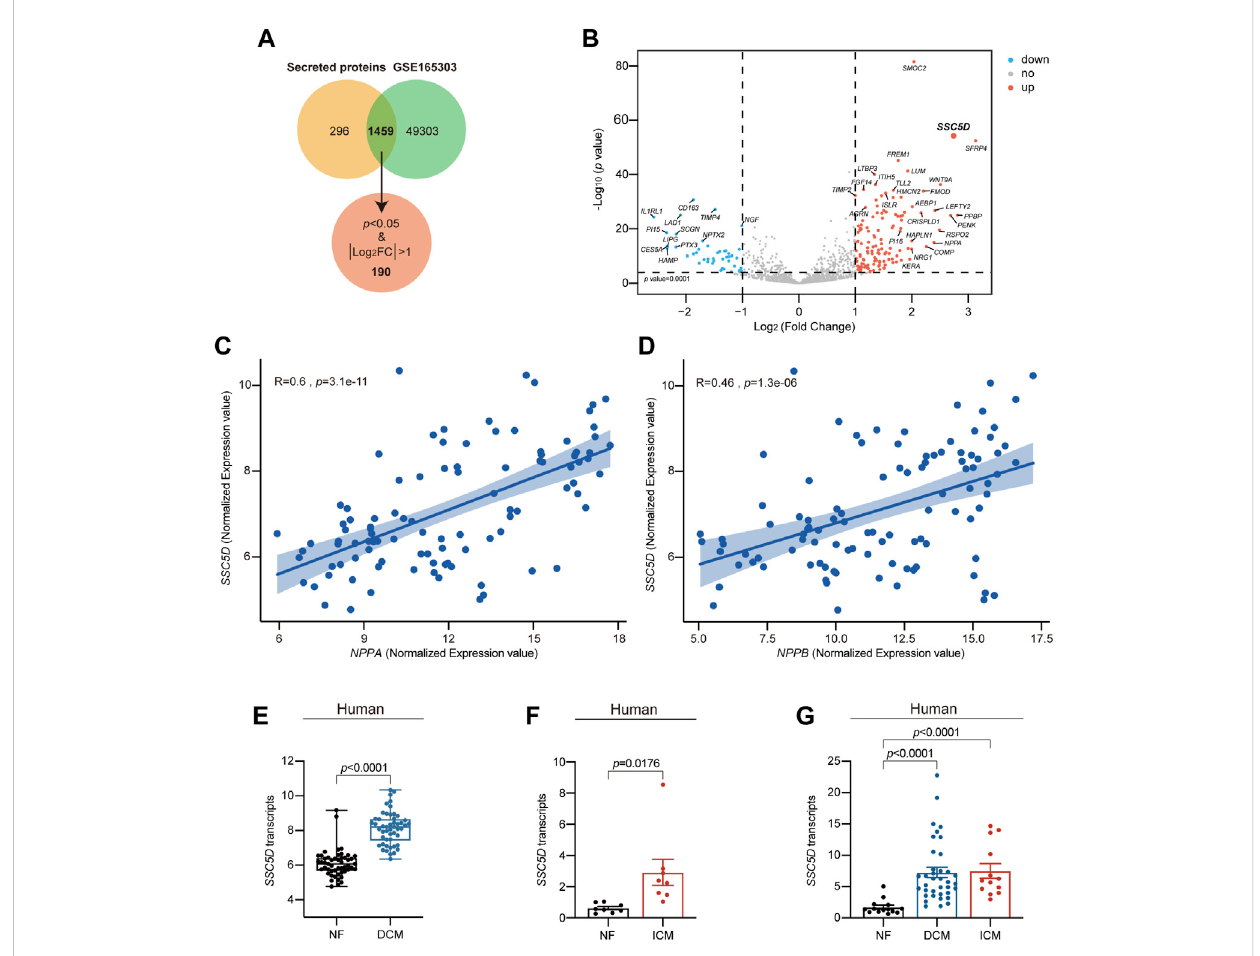
FIGURE 1 SSC5D transcript is highly elevated in failing hearts. (A) The Venn diagram shows the common genes between the secreted proteins and GSE165303data. (B) Thevolcanomapshowsthesigni fi cantlydifferentiallyexpressedgenesamong1,459commongenes.Reddots,signi fi cantlyelevated genes;Bluedots, signi fi cantly downregulatedgenes;Greydots,non-signi fi cantly alteredgenes. (C,D) Thecorrelationbetween SSC5D (log2[normalized counts]) and NPPA , NPPB (log2 [normalized counts]) in 51 NF and 50 DCM hearts RNA-seq data (GSE165303). (E) Normalized SSC5D expression values (log2 [normalized counts]) in 51 NF and 50 DCM human hearts RNA-seq data (GSE165303). (F) Normalized SSC5D expression (RPKM) in 8 NF and 8 ICM human hearts RNA-seq data (GSE46224). (G) Normalized SSC5D expression (RPKM) in 14 NF, 13 ICM and 37 DCM human hearts RNA-seq data (GSE116250). NF, non-failing; DCM, dilated cardiomyopathy; ICM, ischemic cardiomyopathy; p -value < 0.05 was considered statistically signi fi